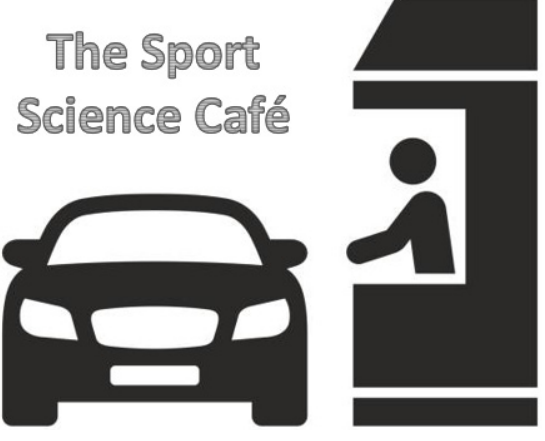
Figure 1. “The Sport Science Café”.